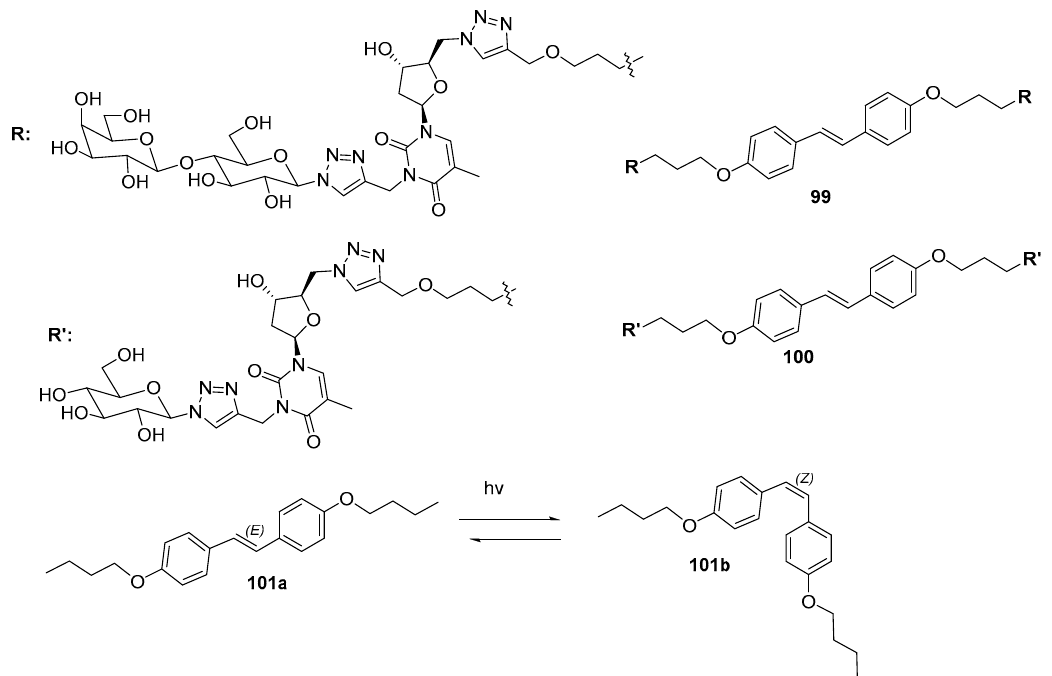
Figure 59. Structures of light-sensitive glycosylated nucleoside-based bolaamphiphiles (GNBAs) 99 – 100 [114].